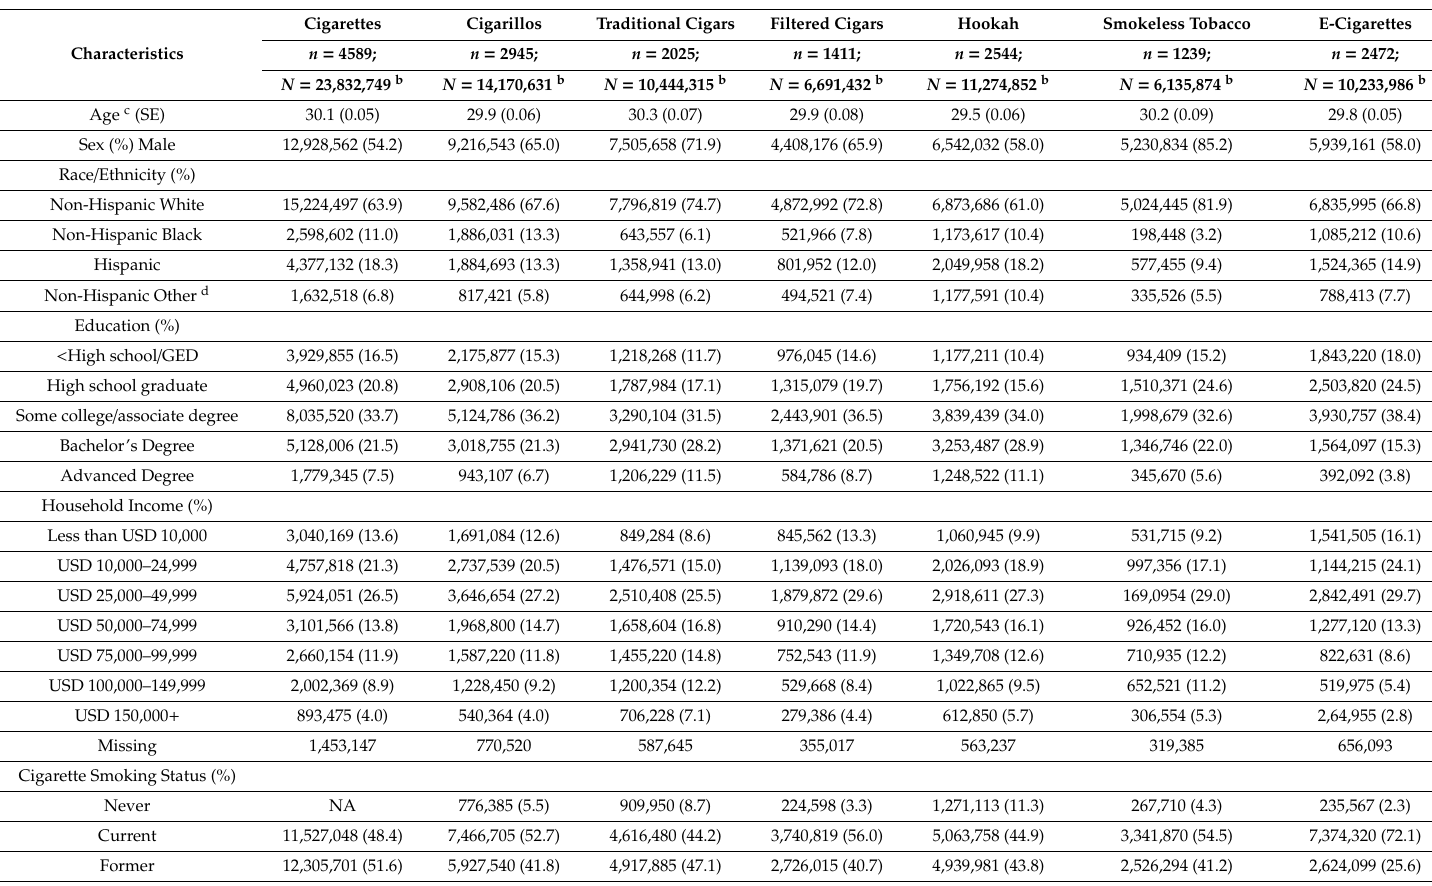
Table 1. Sociodemographic characteristics of 26–34 year old adults from PATH a 2013–2014 (wave 1) who reported ever use of each of the seven tobacco products.